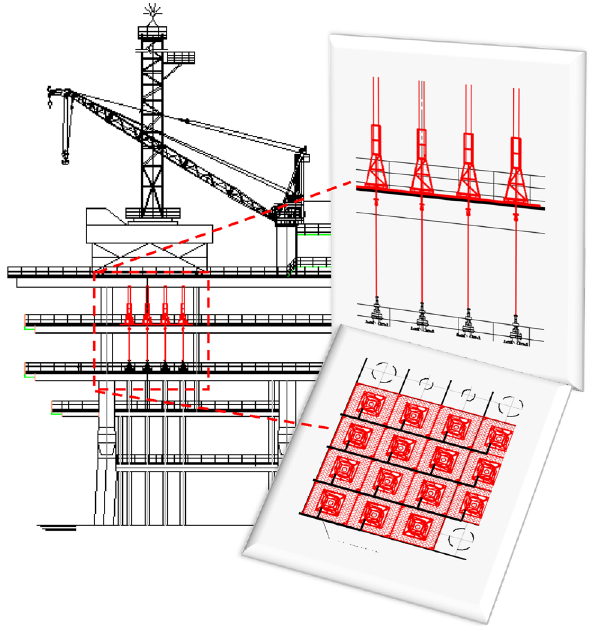
Fig. 1 Schematic diagram of LD27-2 WHPB platform installation for pumping